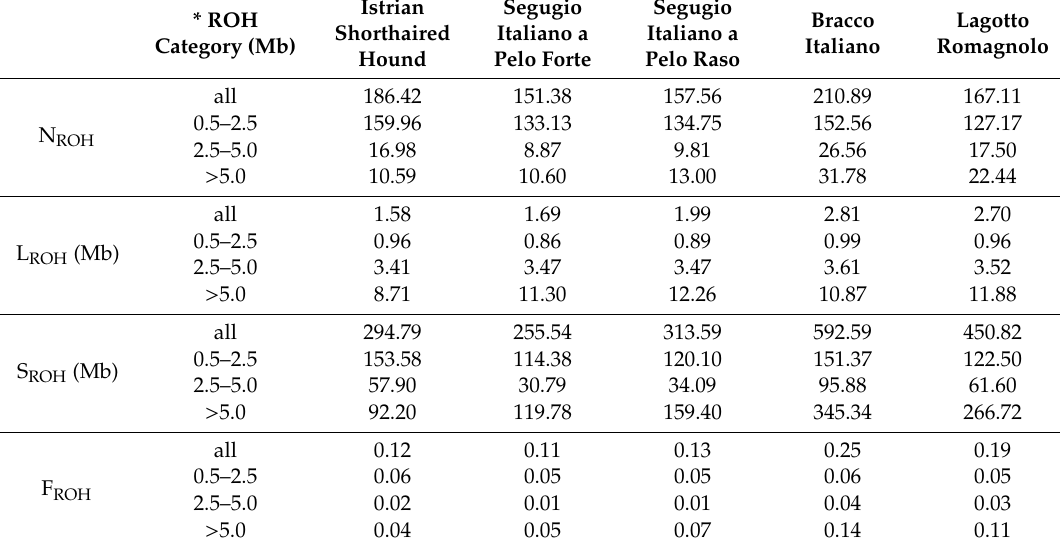
Table 4. ROH summary: mean number of ROH (N ROH ), mean ROH length (L ROH ) and mean genome length covered by ROH (S ROH ) for Istrian shorthaired hound and four related Italian dog breeds.